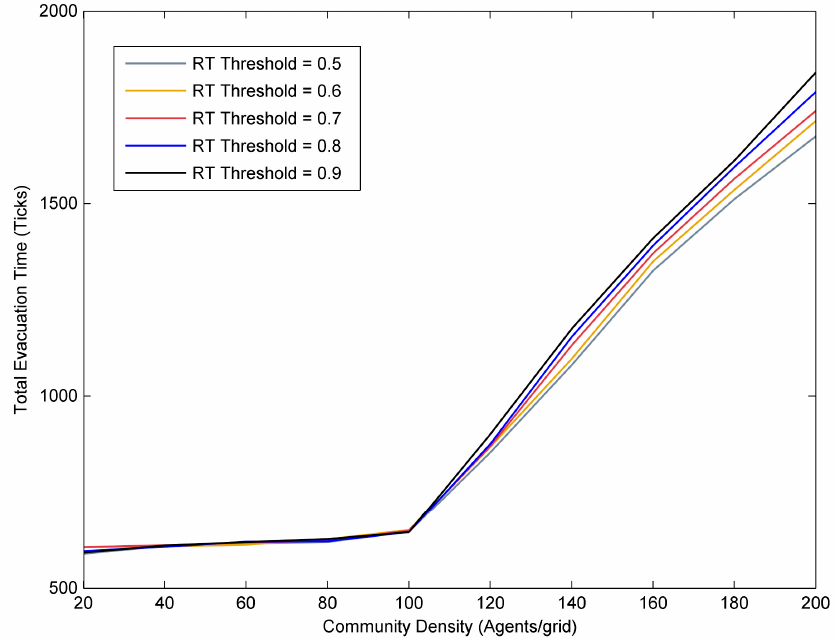
Figure 7. The impacts of residents’ flood risk tolerance threshold on the total evacuation time.